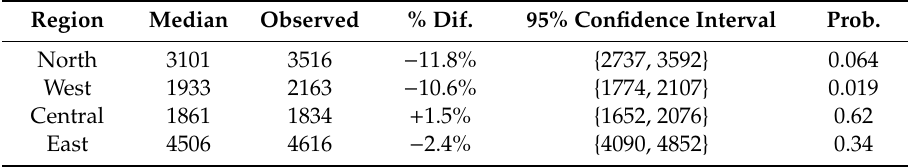
Table 13. Results for the Number of Events’ test for the di ff erent regions. The estimated ETAS model for each region is used to simulate N SIM = 100 catalogs. The median and 95% confidence interval are calculated for the simulated catalogs, as well as the relative di ff erence (% dif.). Furthermore, the probability (Prob.) that we observe the number of events in the event catalog or more events is in the final column.